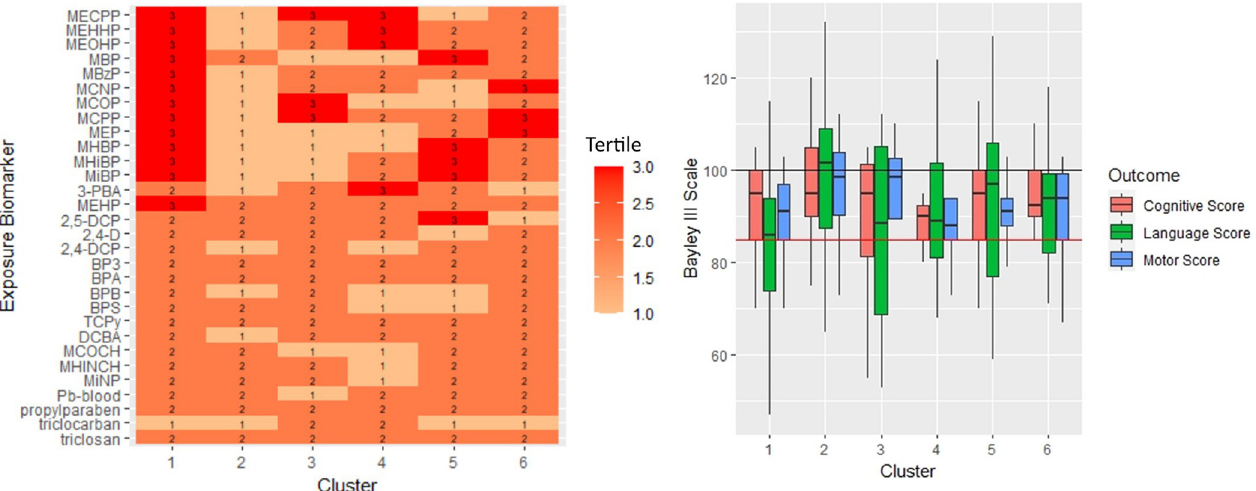
Fig 2. A) Exposure Biomarkers by Clusters: Heatmap to visualize the median (most typical) tertile of exposure that each chemical falls within for each cluster. Darker red colors indicate tertile 3 (highest exposure group), orange colors indicate tertile 2 (medium exposure group), and light orange indicate tertile 1 (lowest exposure group). B) Unadjusted Neurodevelopmental Scores by Cluster: Box and whisker plots of neurodevelopmental scores (unadjusted) for each cluster. Black lines within each boxplot represent the median value and the upper and lower ends of the boxes represent the 75th and 25th percentiles, respectively. The horizontal red line on the graph indicates 1 standard deviation (85) below population mean